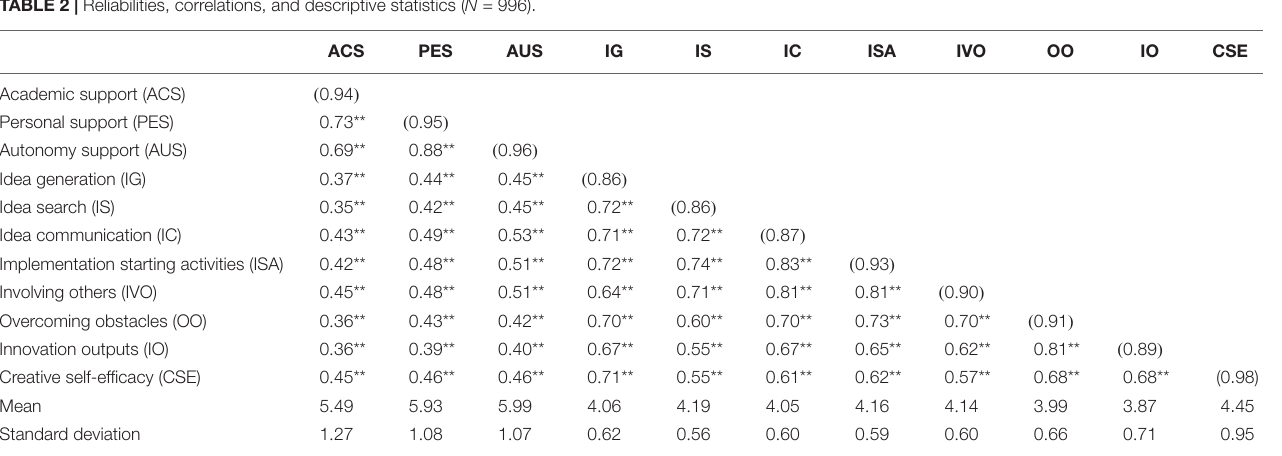
TABLE 2 | Reliabilities, correlations, and descriptive statistics ( N =